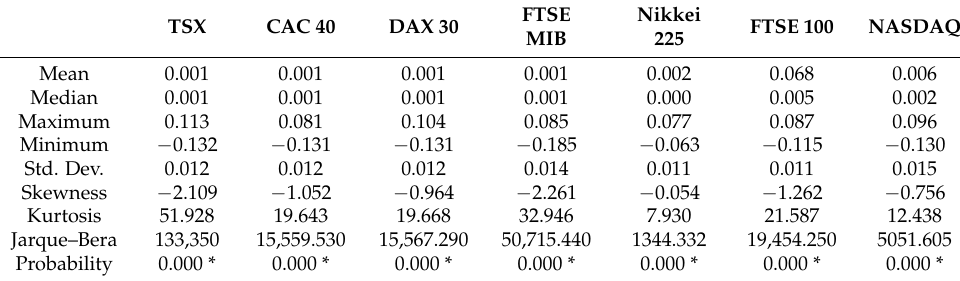
Table 1. Descriptive Statistics Results of Stock Market indices.